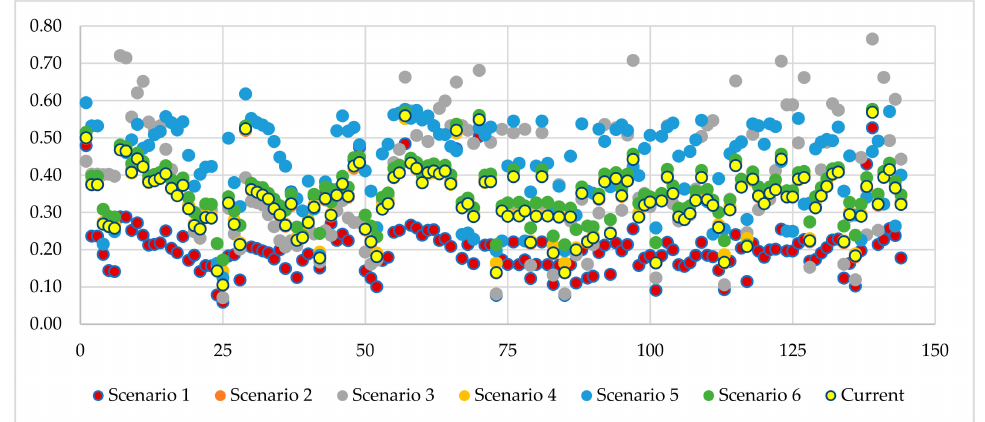
Figure 8. Ranking changes of current EVCSs due to changed criteria weights.